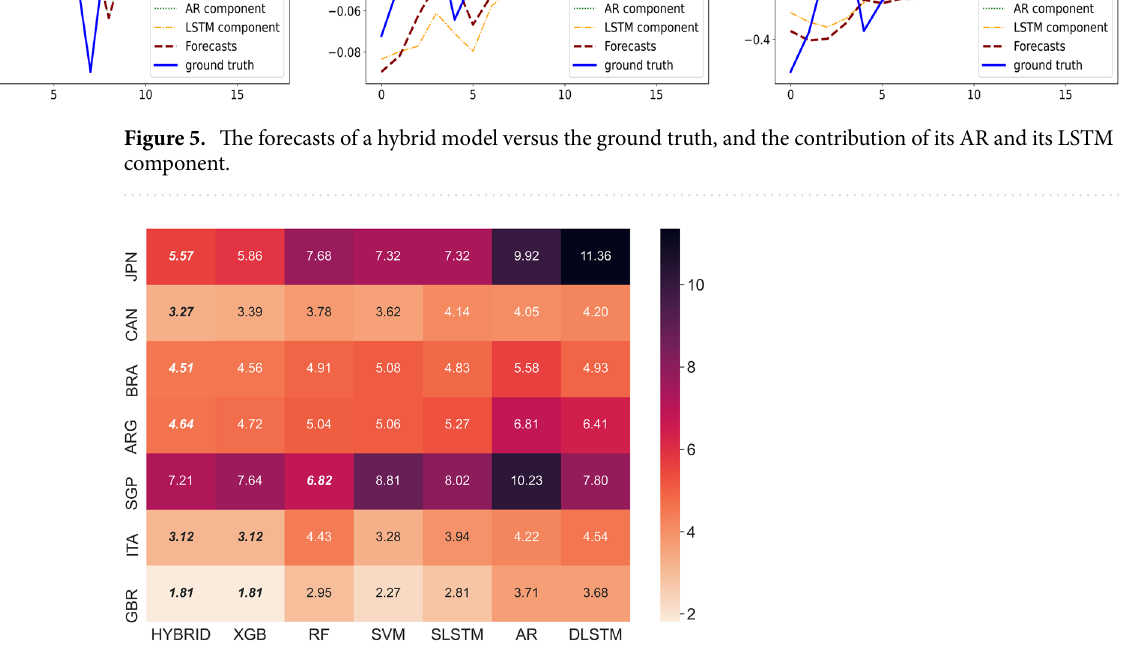
Figure 6. A heatmap exhibiting the performance, measured by MAPE in percentage, of the 7 models from this study and from previous work: AR, Single LSTM(LSTM), Double LSTM(DLSTM), hybrid, SVM, Random Forest(RF), XGBoost(XGB). The assessment has been done on data collected by World Health Organization, from 7 different countries around the world: Japan(JPN), Canada(CAN), Brazil(BRA), Argentina(ARG), Singapore(SGP), Italy(ITA), and The United